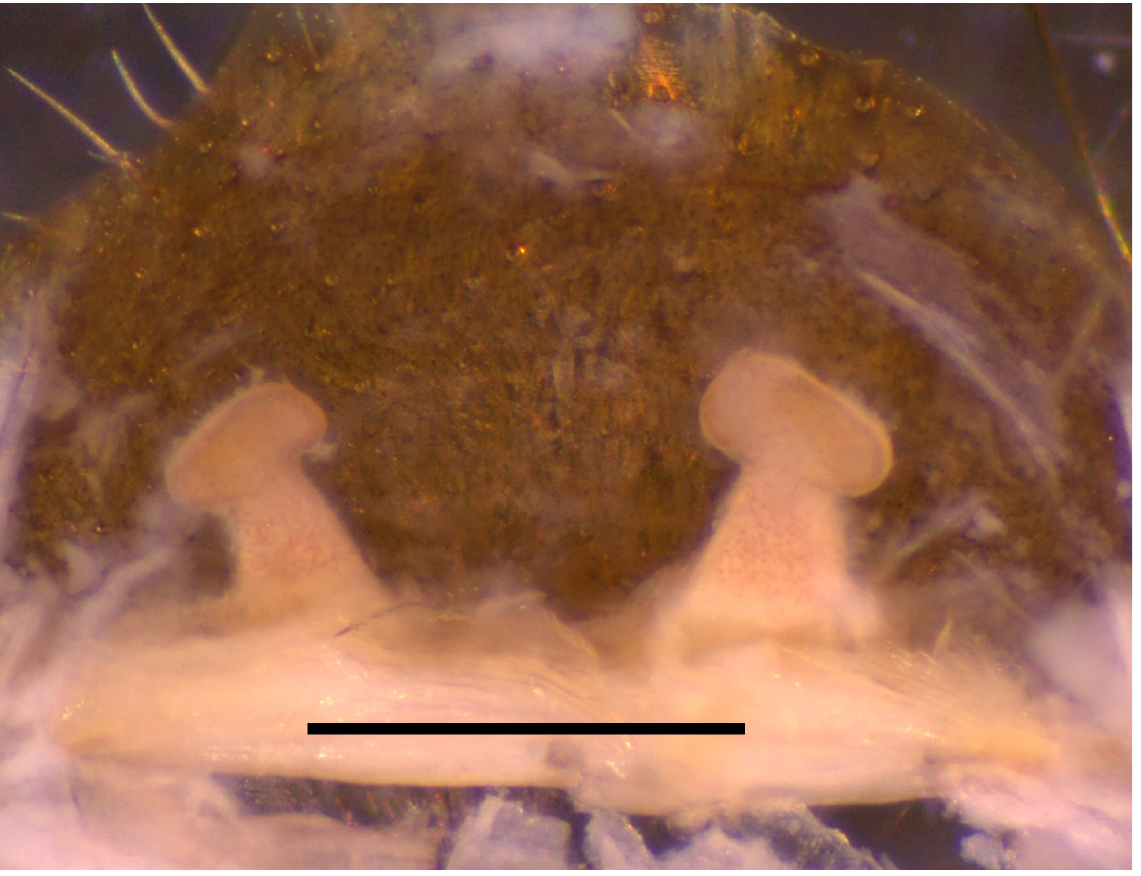
Fig. 13. Bistriopelma kiwicha sp. nov., paratype, ♀ (MUBI 41); spermathecae, dorsal view. Scale bar = 1